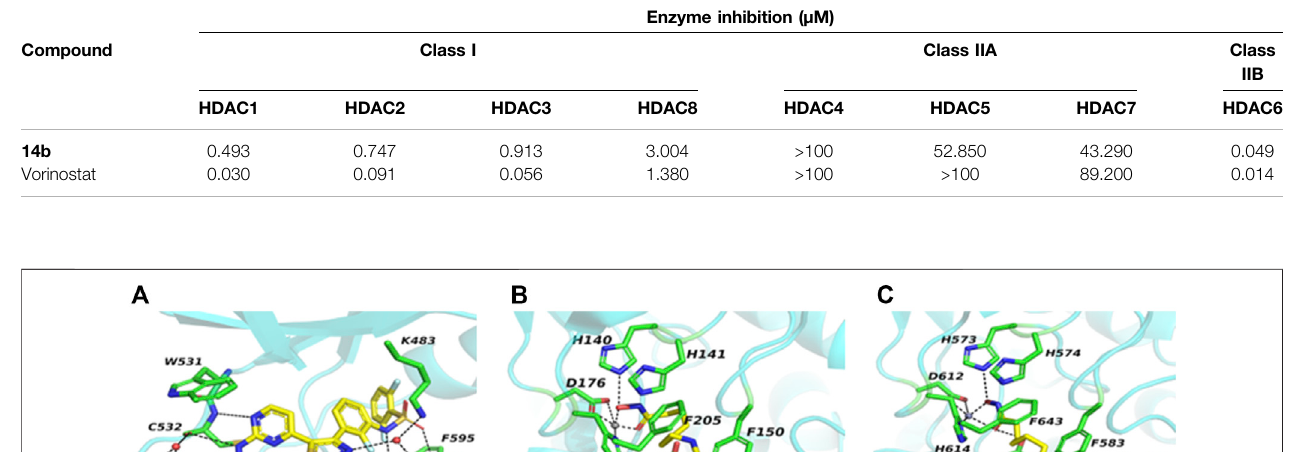
TABLE 3 | Selectivity of 14b and vorinostat in HDAC enzyme.